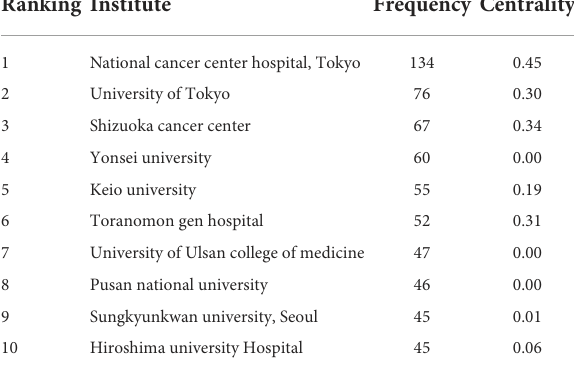
(12, 42–48). 8 out of the top 10 prolific authors were members TABLE 2 Top 10 prolific institutes in research of ESD,